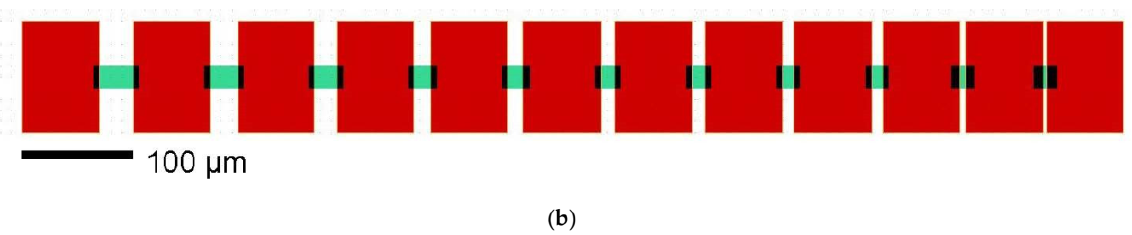
Figure 1. ( a ) Computer-aided design (CAD) schematic of the device designs studied here. Note that four die were printed on a chip (8 × 8 mm 2 area). The devices are classified into four groups based on graphene film patterning: (1) unpatterned (labeled “U”) and interdigitated group (labeled “I 1 , I 2 , I 3 , I 4 ”); (2) patterned with horizontal slots (labeled “H 1 , H 2 ”); (3) patterned with vertical slots (labeled “V 1 , V 2 ”); (4) patterned with 2D patterns (labeled “MS, MC, ME 2 , ME 7 ”). Detail of the 2D patterns is shown in the inset. Descriptions are provided in Table 1. ( b ) CAD schematic of the TLM structures. The graphene mesas are 20 µ m wide, the 70 µ m × 100 µ m Ti/Au pads overlap the graphene by 5 µ m, and the uncovered lengths are 30, 25, 20, 15, 14, 13, 12, 11, 10, 5, and 3 µ m. Table 1. Detailed description of the four graphene chemiresistive device group structures shown in Figure 1. The terms “horizontal” and “vertical” refer to the graphene pattern with respect to the direction of charge transport, parallel or perpendicular, respectively. “Constricted channel width” refers to the minimum graphene channel width after etching, i.e., overall film width less total hole cross